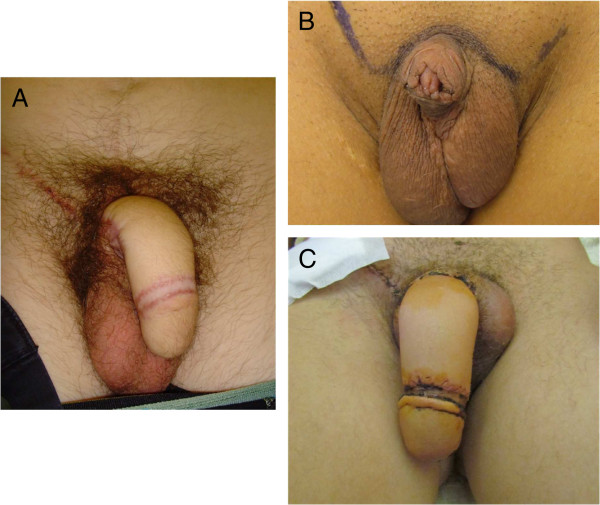
Results of phalloplasty for 2 46,XY boys. Genitalia of: A. Exstrophy patient who lost his penis during reconstructive surgery, B. Preoperatively of Partial Androgen Insensitivity Syndrome (PAIS) patient with an insufficient penis after multiple hypospadias repairs. C. Post-operative PAIS after phalloplasty and subsequent implant one year later. Kindly provided by Piet Hoebeke, Department of Urology, University Hospital, Gent, Belgium.